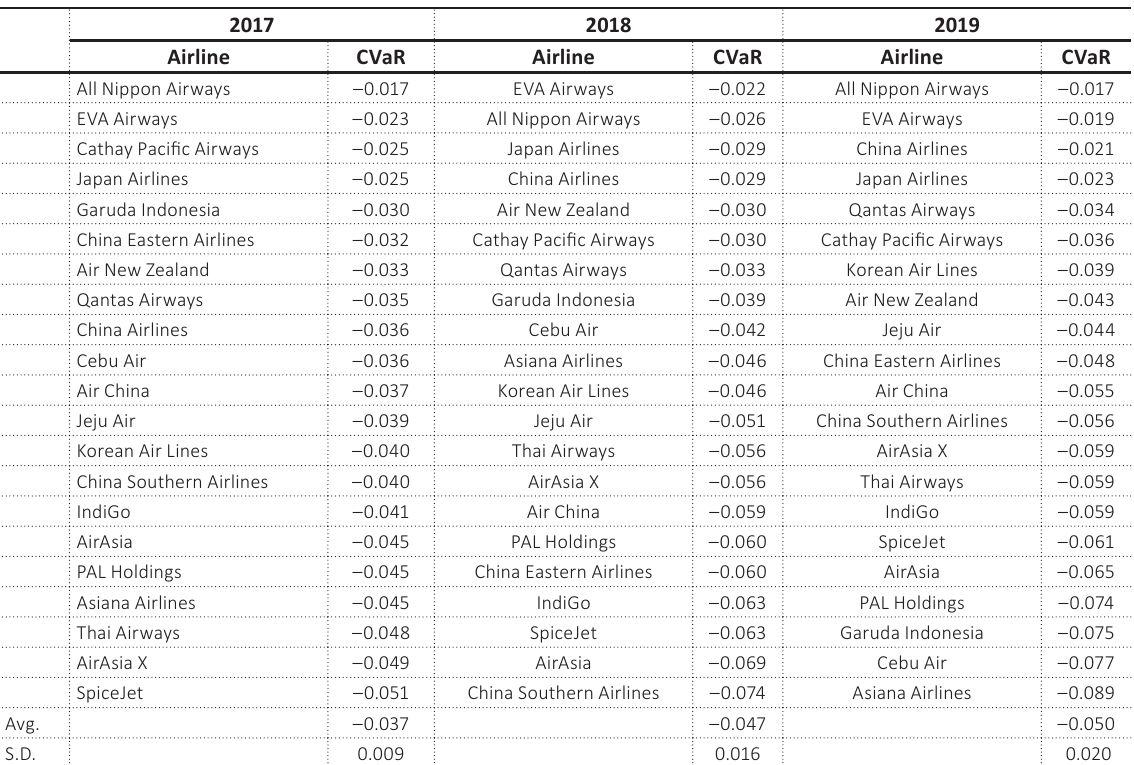
Table 5. CVaRs for airline stock